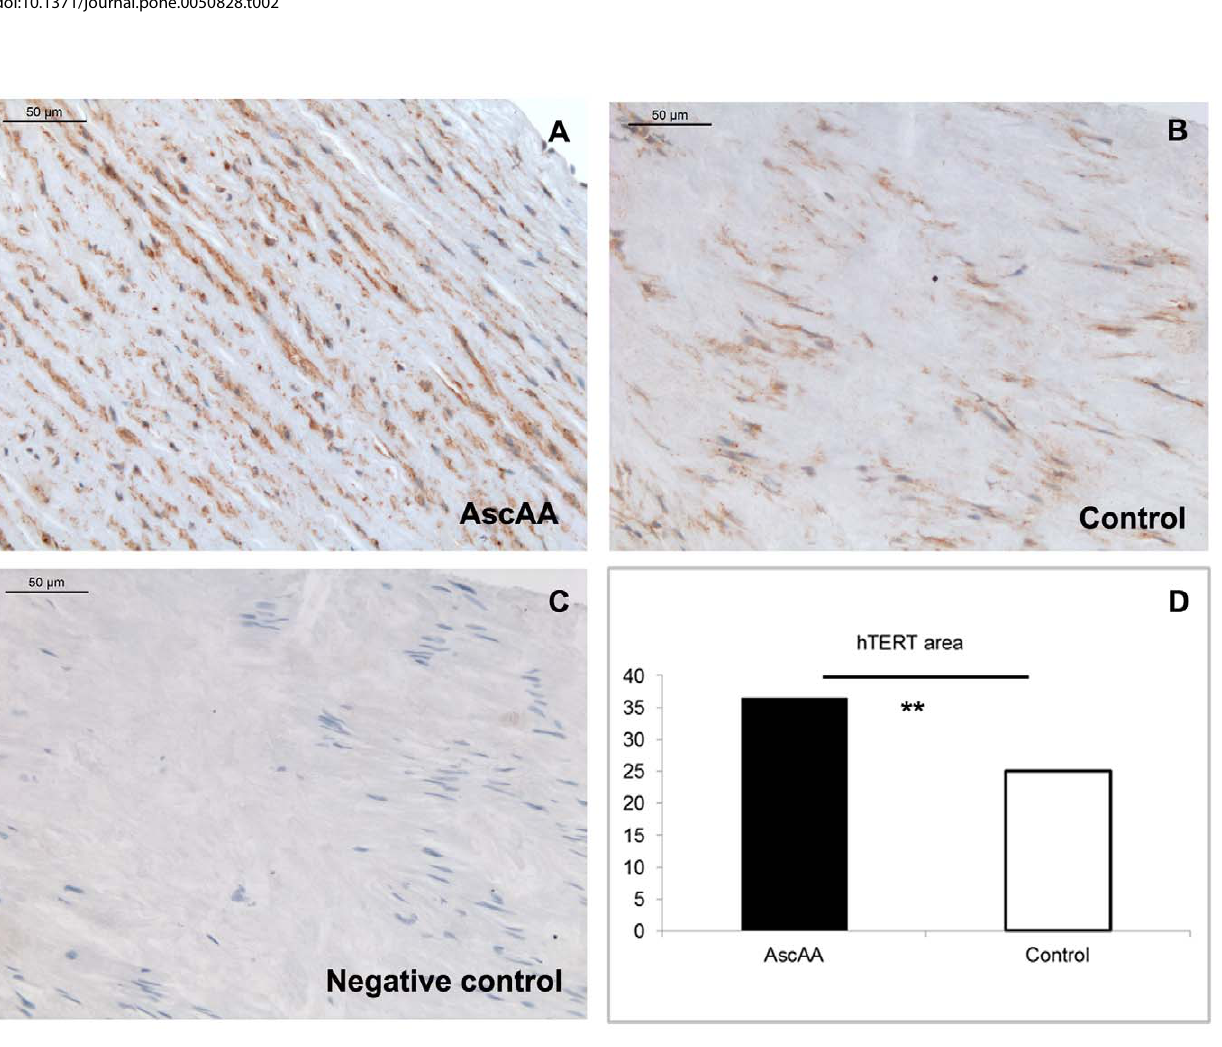
Figure 1. Immunostaining of hTERT in A) AscAA, B) control aorta and C) negative control slides (original magnification 6 20). Quantified immunostained areas of hTERT protein in AscAA and control aorta slides are presented in a bar chart (D). Statistically significant differences between the groups are marked as **(p , 0.01). AscAA , ascending aortic aneurysm, hTERT , telomerase.